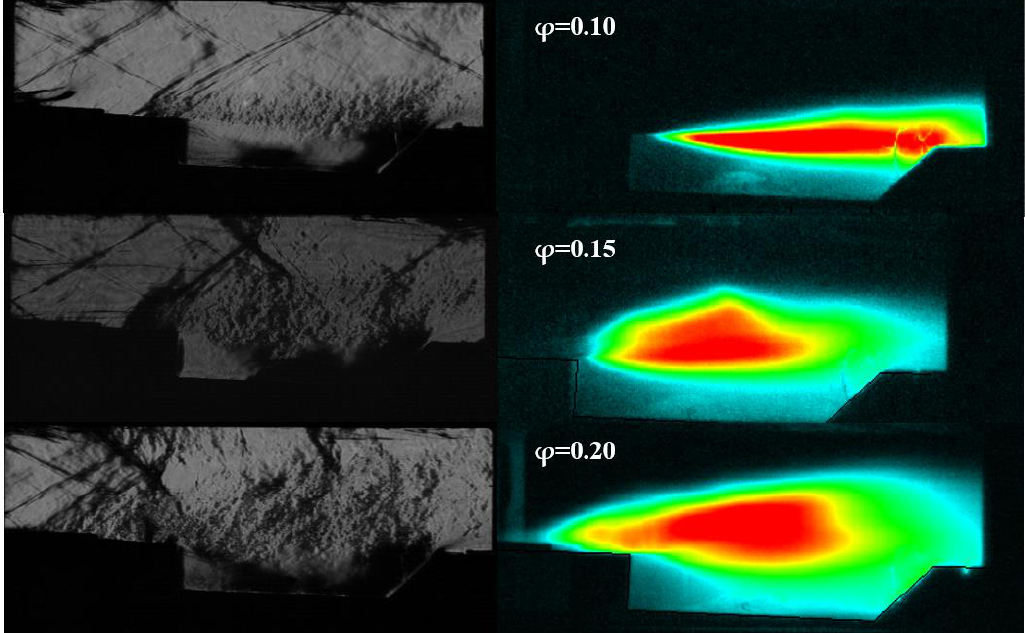
Figure 5. Schlieren and pseudo-color images of averaged flame CH* chemiluminescence.